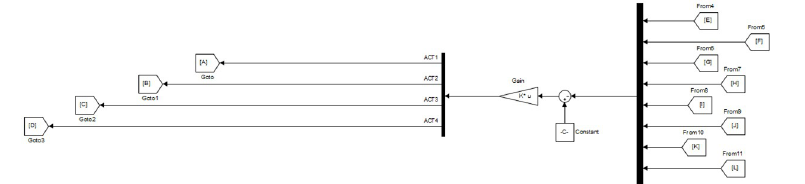
Fig 3. LQR state feedback control in